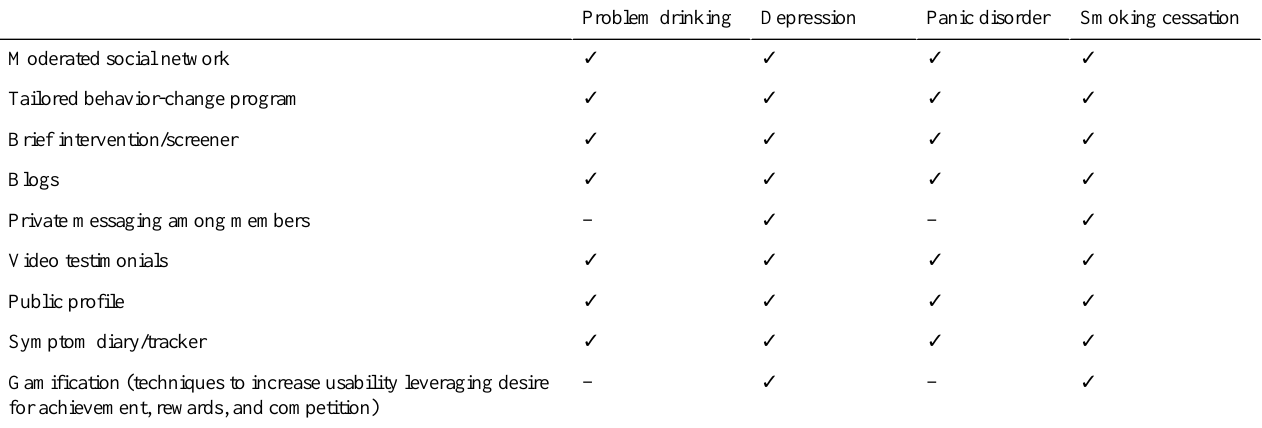
Table 1. Program features and functionality.